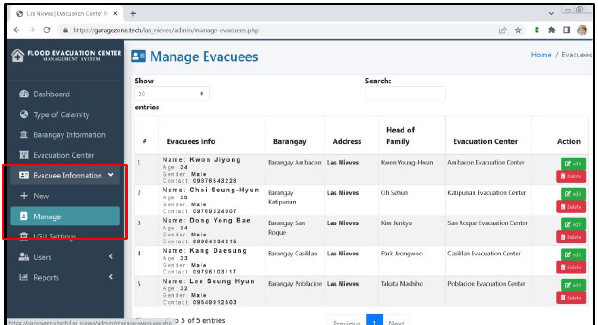
Figure 20. The Page where the Administrator will manage the Added Evacuees